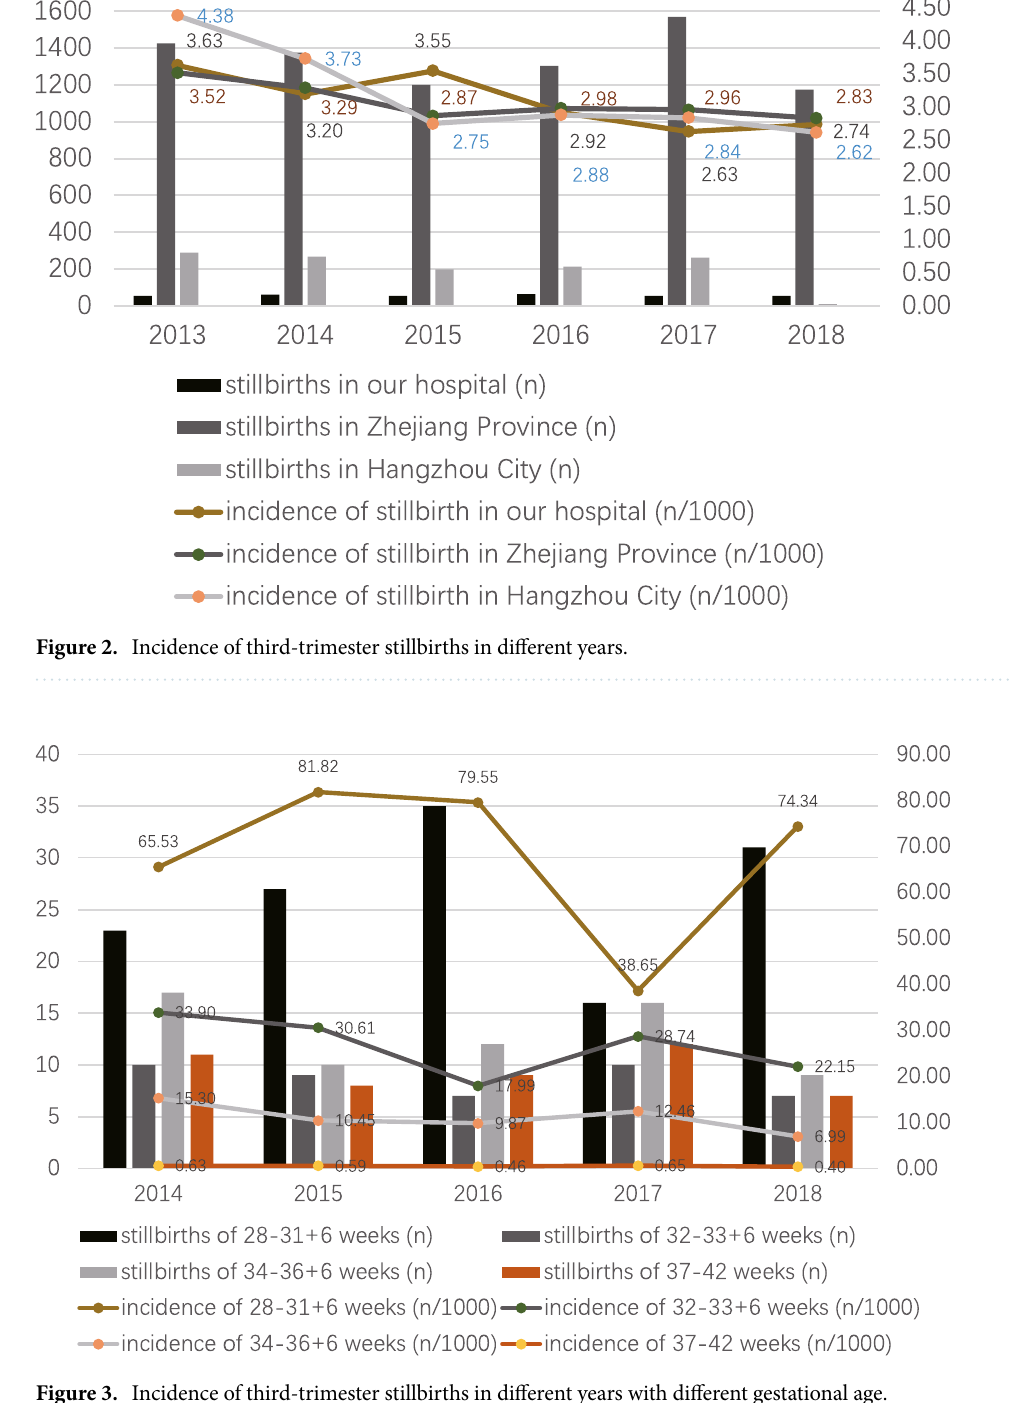
Figure 3. Incidence of third-trimester stillbirths in different years with different gestational